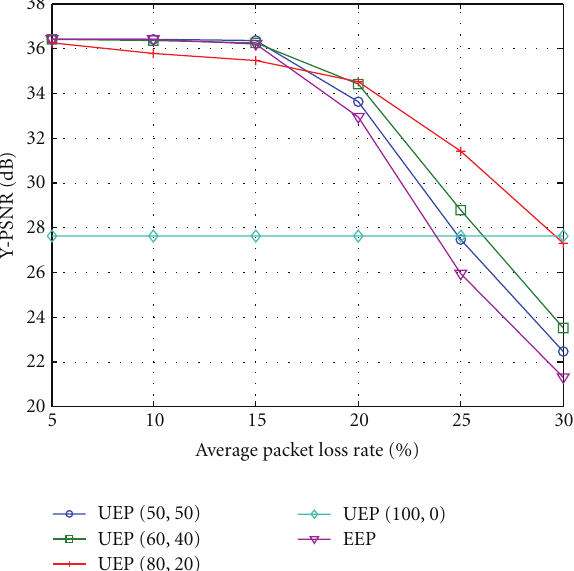
Figure 5: PSNR versus average PLR for the proposed scheme and the EEP scheme.